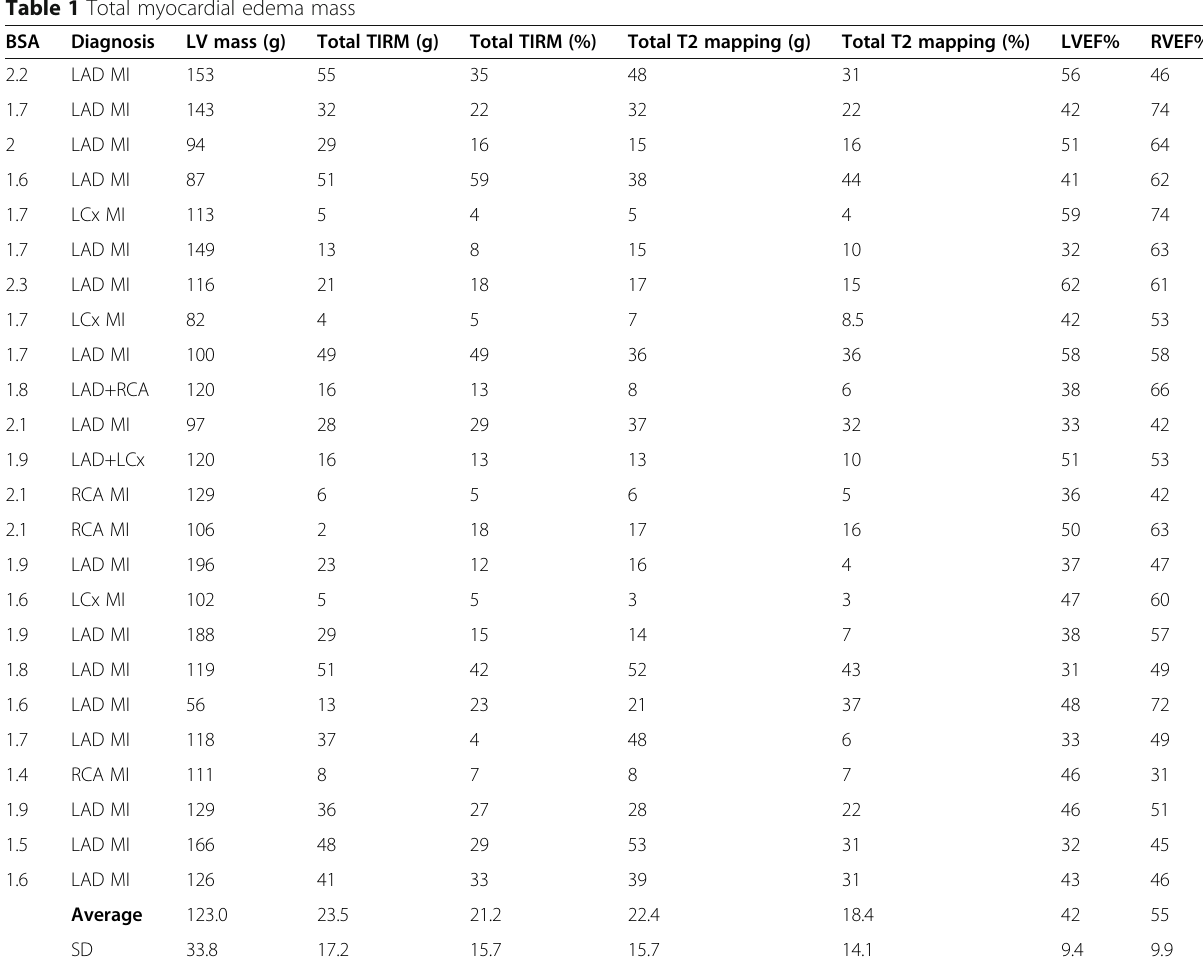
Table 1 Total myocardial edema mass